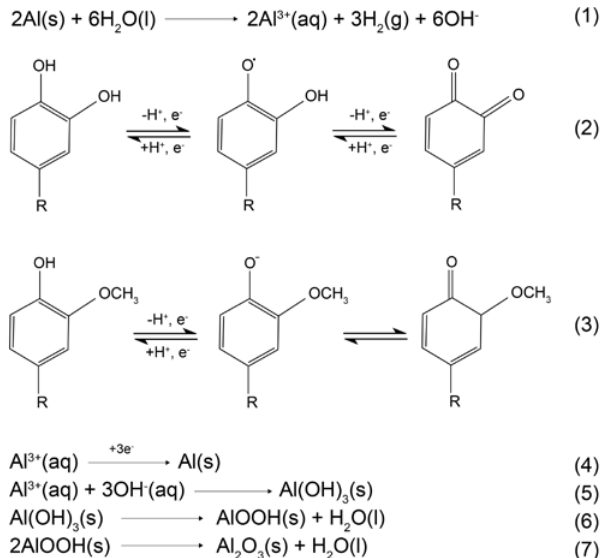
Figure 8. Proposed mechanism of the Al dissolution rate decrease by phenolic acids and the formation of Al 2 O 3 , R: CH=CHCOOH or CH=CHCOO − .